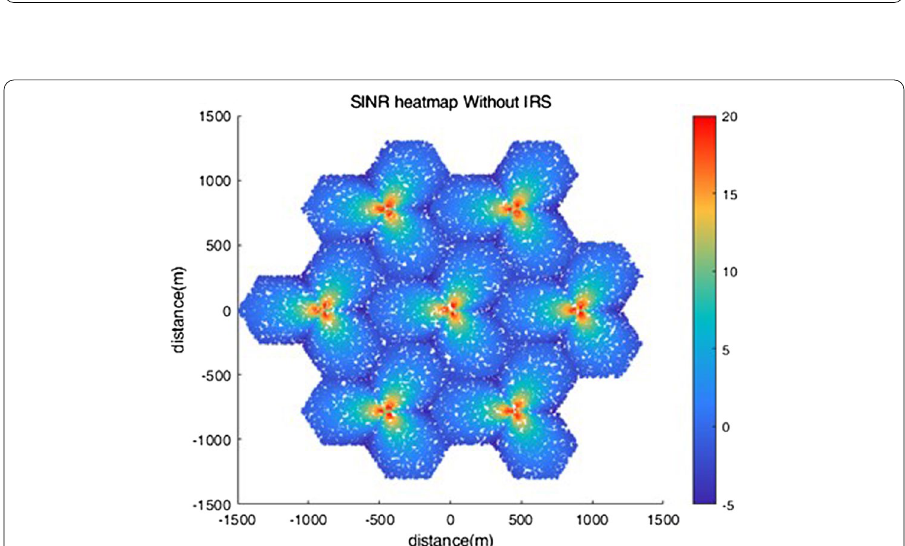
Fig. 7 SINR heatmap without IRS. From the figure, it can be seen that the received SINR of UE has